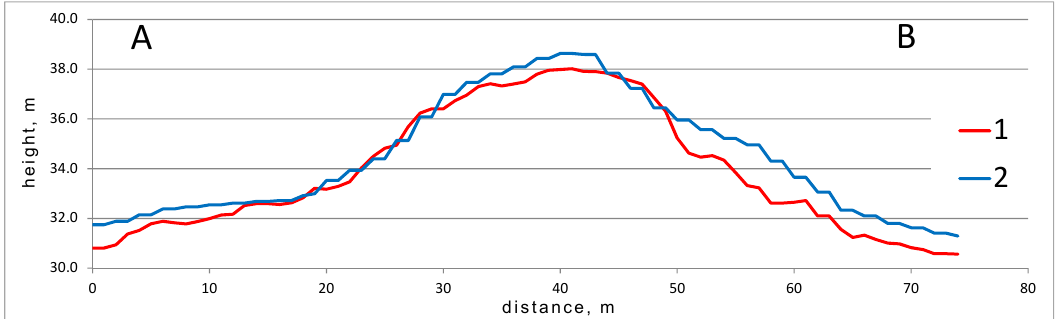
Figure 8. A comparison of elevation profiles plotted using the author’s DSM for GEC-1 (1), with ArcticDEM (2). Both lines are not smoothened. Figure 2a shows the spatial position of the profile AB across the GEC-1 mound-predecessor.